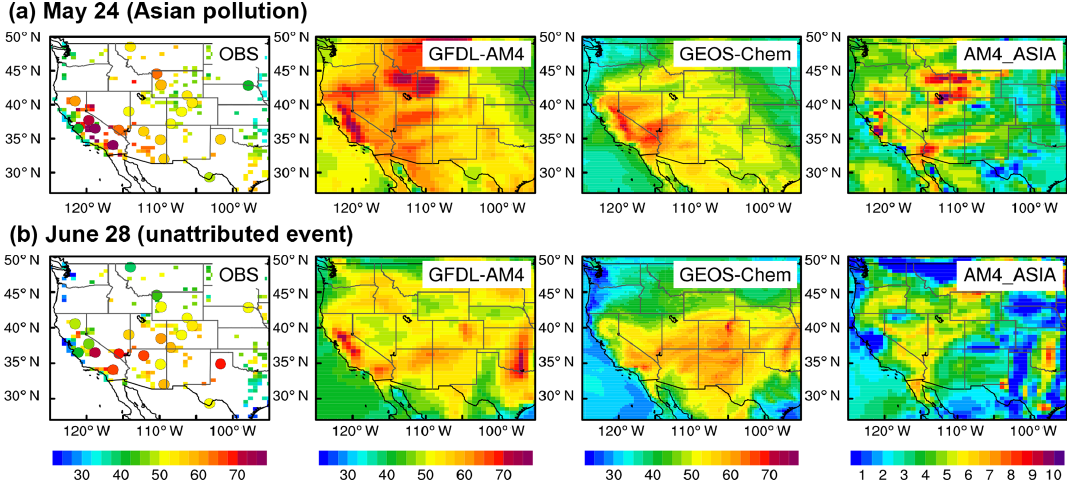
Figure 15. Same as Fig. 9 but for (a) the Asian pollution event on 24 May and (b) the unattributed pollution event on 28 June 2017. The right panels show O 3 enhancements from Asian pollution estimated by